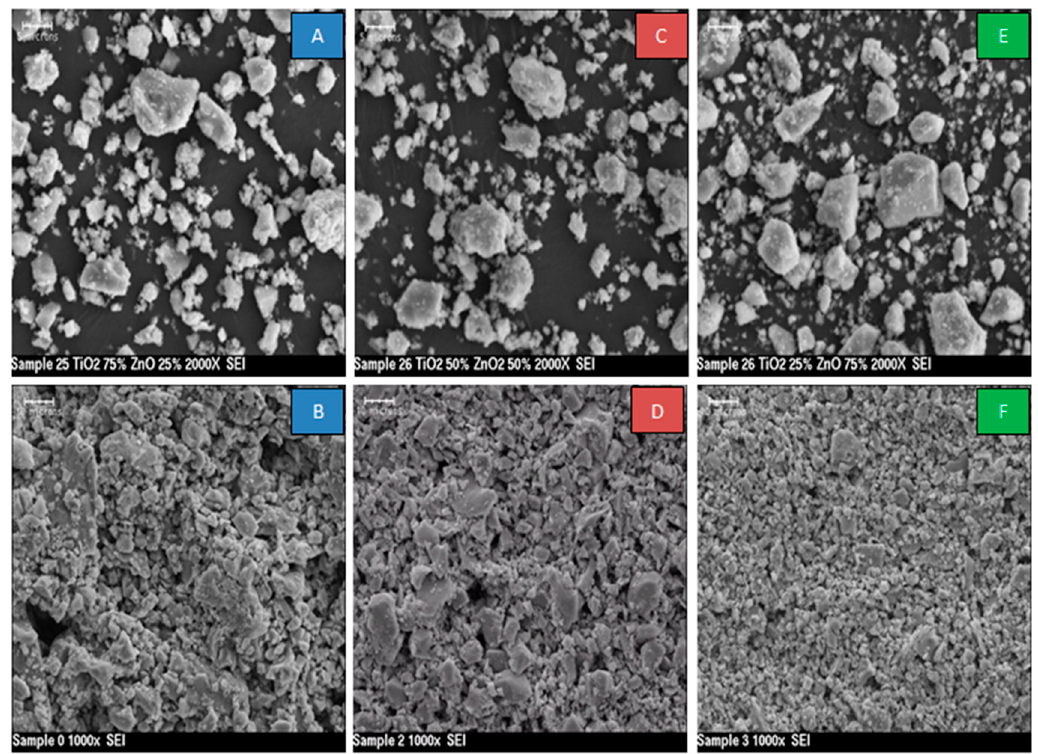
Figure 3. SEM images of TiO 2 /ZnO mixed powder ( A , C , E ) and screen-printed sensing material ( B , D , F ) for Sample 1–3 respectively.